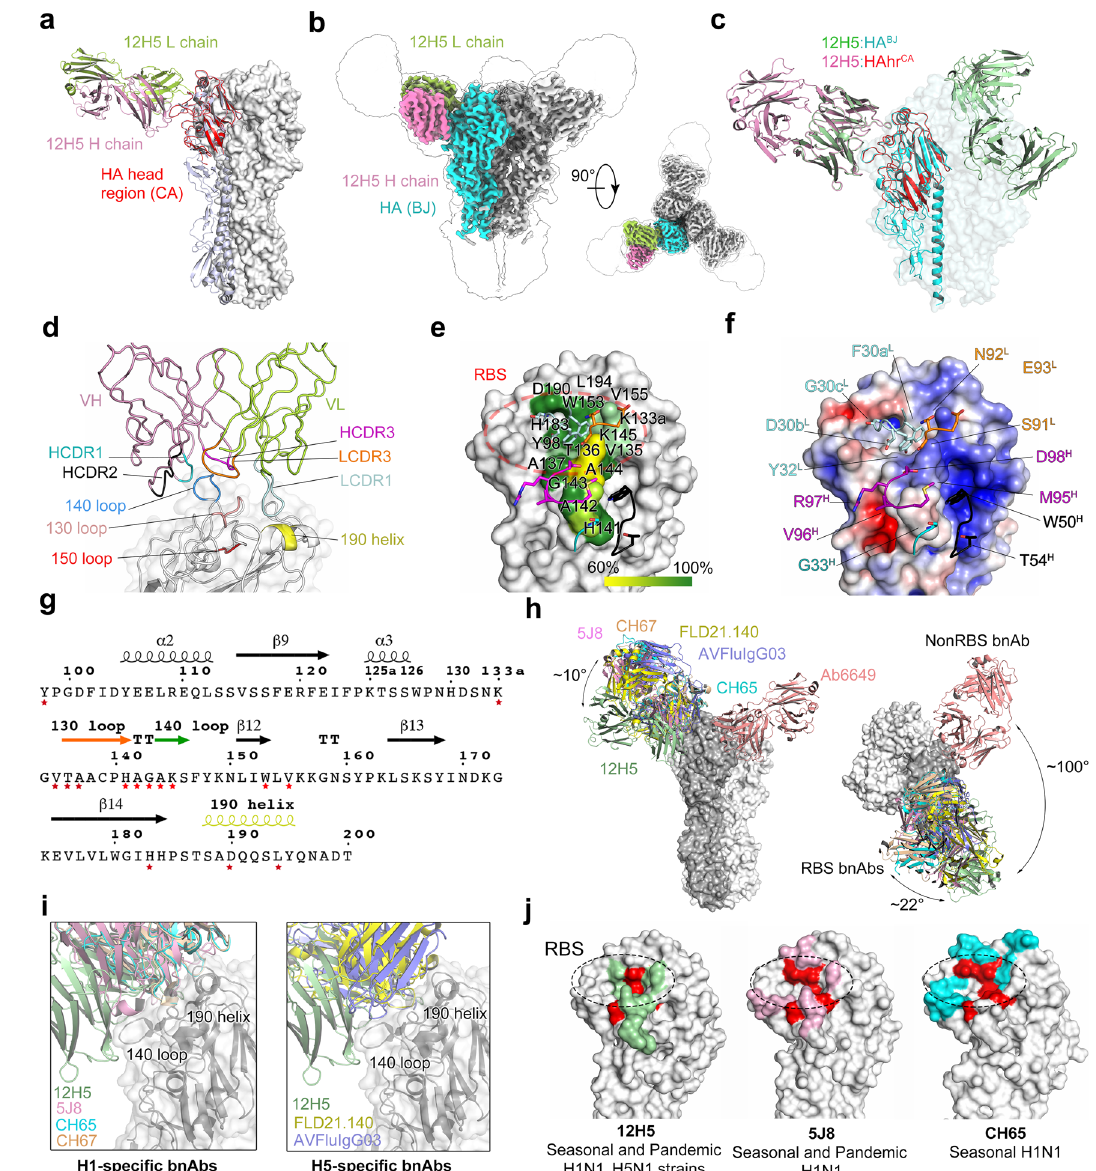
Fig. 5 | Structure of 12H5:H1 HA complex. a The crystal structure of 12H5 in complexwithHAofCA4/2009(12H5HAhr CA complex).TheCAHAheadregion(i.e., HAhr CA )ofthe12H5:HAhr CA complexwassuperimposedontooneprotomerofaCA HA trimer (PDB code: 3lzg). The HA head region is in red, one protomer of the HA trimer is in light purple; the light chain and heavy chain of 12H5 are in light green andpink,respectively. b TheoverallCryo-EMstructureof12H5incomplexwithHA trimerfromBJ/1995(12H5:HA BJ )at3.15Åresolutioninsideviewandtopview. c The 12H5:HA BJ structure allowed the exact fi t of the crystal structure of 12H5: HAhr CA complex. d to f Interactionanalysisof12H5:HAhr CA complex. d Close-upviewofthe interface of the 12H5: HAhr CA complex. e Sequence conservation of the 12H5 epi- tope. HAisinsurfacerepresentation, and the conservationof the epitope residues inH1N1subtypesarecolor-codedonthesurface. f Electrostaticpotentialsurfaceof